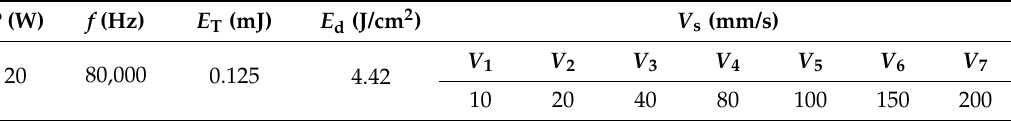
Table 1. Laser processing